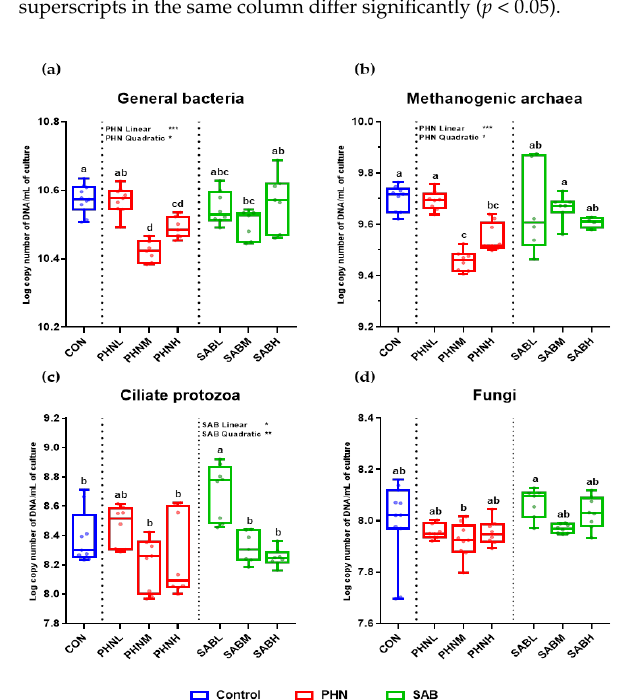
Figure 1. Effects of bamboo leaves addition on the population of general bacteria ( a ), methanogenic archaea ( b ), ciliate protozoa ( c ), and fungi ( d ) (Log copy number of DNA/mL of rumen fluid) at 48 h incubation time. Error bars are standard error of the mean ( n = 4). abcd Means with different superscripts in the same row indicate significant differences ( p < 0.05). Orthogonal contrasts for linear and quadratic effects were considered statistically significant at * p < 0.050, ** p < 0.010, and *** p < 0.001.